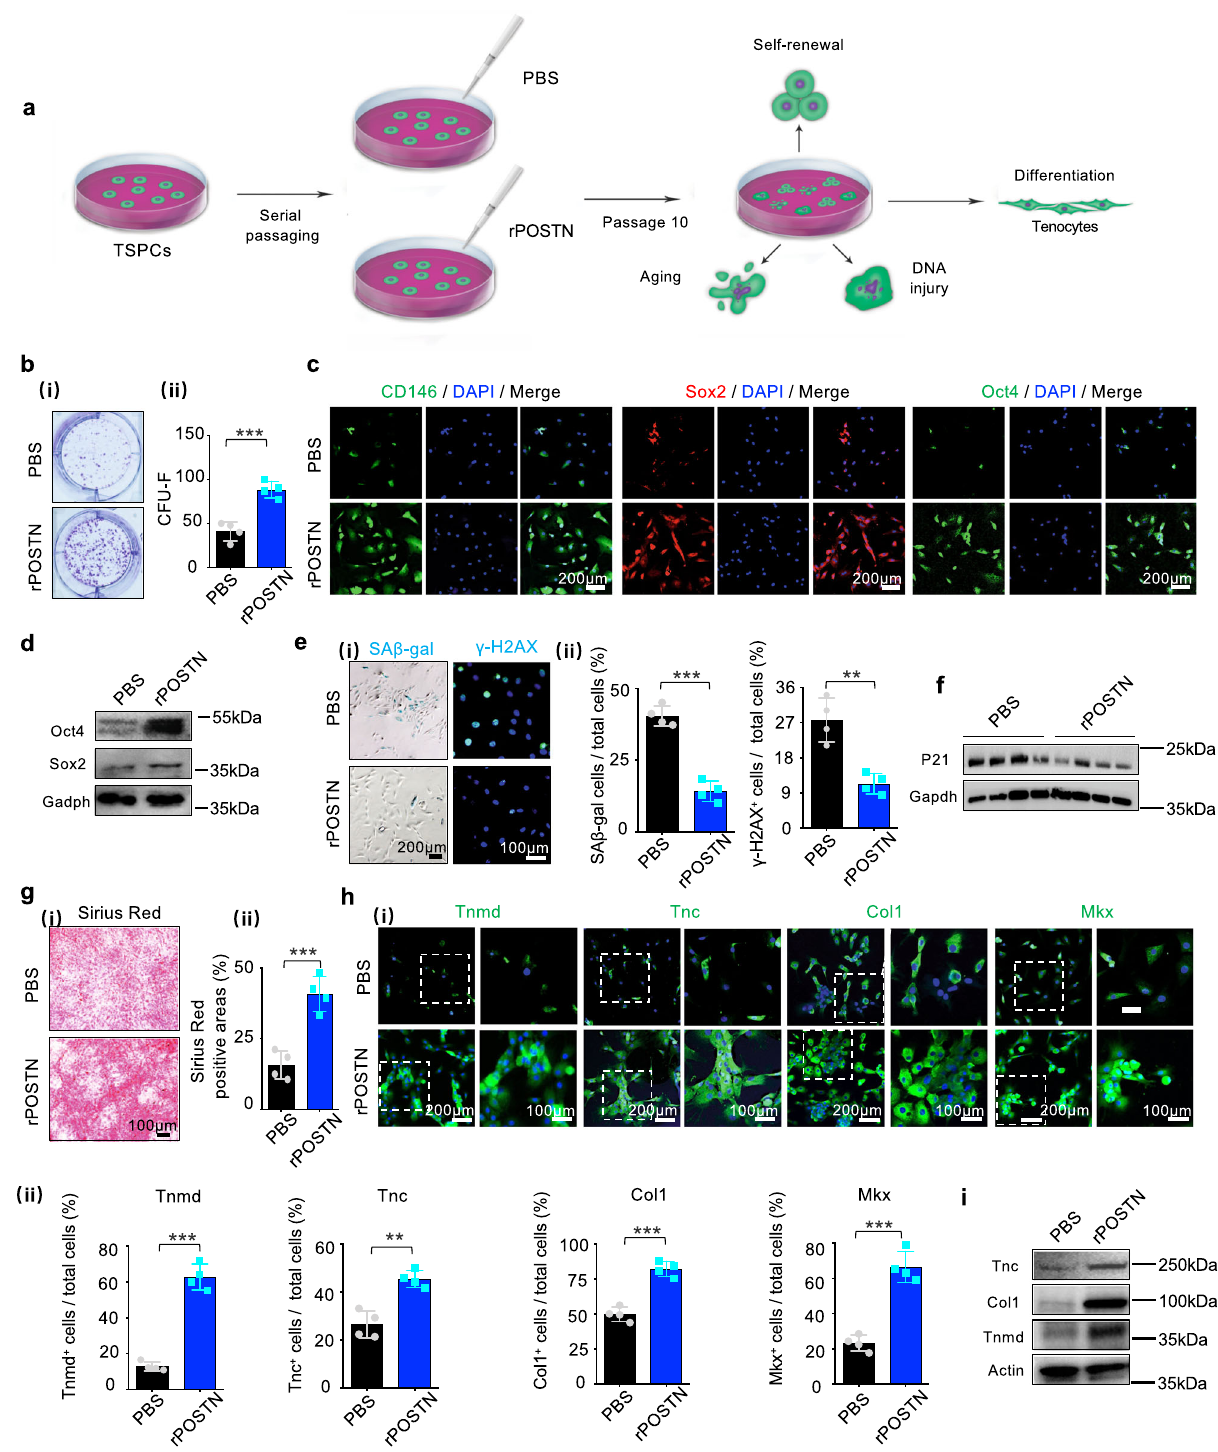
Fig. 3 Postn maintains TSPC phenotype and functions after long-term passage in vitro. a Schematic of the TSPC serial passaging. b (i) CFU-F assay of PBS- and rPOSTN-treated TSPCs. (ii) Semi-quanti fi cation of (i) ( n = 4 biologically independent samples). c Immuno fl uorescence staining of stemness- related markers Sox2 and Oct4, and tendon stem cell marker CD146 of PBS- and rPOSTN-treated TSPCs ( n = 4 biologically independent samples). d Western blotting of Sox2 and Oct4 protein levels of PBS- and rPOSTN-treated TSPCs. e (i) SA β -gal staining (left panel) and immuno fl uorescence staining of DNA injury-related protein γ -H2AX (right panel) of PBS- and rPOSTN-treated TSPCs. The blue cells are senescent cells. (ii) Semi-quanti fi cation of (i) ( n = 4 biologically independent samples). f Western blotting of P21 protein levels of PBS- and rPOSTN-treated TSPCs. g (i) Sirius Red staining of PBS- and rPOSTN-treated TSPCs in the tenogenic medium after 14 days. (ii) Semi-quanti fi cation of (i) ( n = 4 biologically independent samples). h (i) Immuno fl uorescence staining of tenogenic markers Tnc, Col1, Tnmd, and Mkx in PBS- and rPOSTN - treated TSPCs. (ii) Semi-quanti fi cation of (i) ( n = 4 biologically independent samples). i Western blotting of Tnc, Col1, and Tnmd protein levels of PBS- and rPOSTN-treated TSPCs in tenogenic medium. Data are represented as mean ± SD. Exact P values were calculated by two-tailed Student ’ s t test and given in the Source Data fi le. *** P < 0.001, ** P <